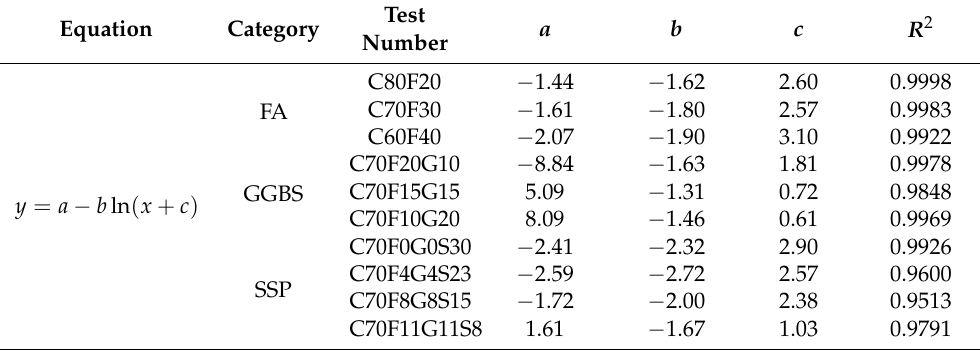
Table 7. Fitting parameters of concrete early shrinkage